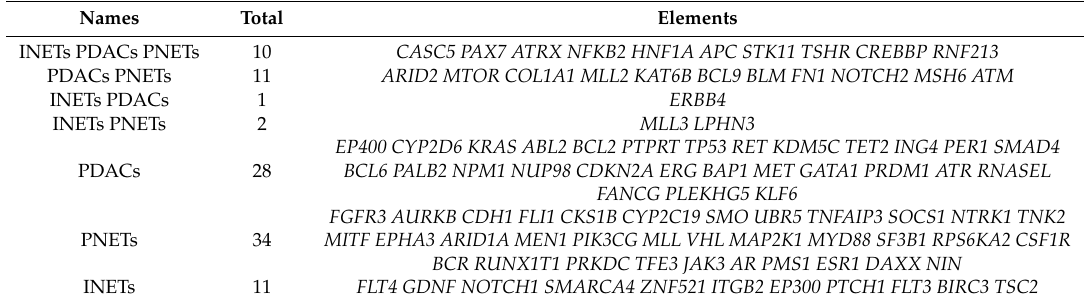
Figure 1. Venn diagram, depicting unique and shared gene numbers carrying deleterious variants across tested tissues. Parallel sequencing of 13 neuroendocrine tumors and 8 ductal adenocarcinomas of the pancreas identified 1288 unique variants across 234 genes, of which 50, 57, and 24 genes carried variants likely to be deleterious in pancreatic ductal adenocarcinomas (PDACs), pancreatic neuroendocrine tumors (PNETs), and intestinal neuroendocrine tumors (INETs), respectively. Table 2. Distribution of likely deleterious variants among the three tumor types.